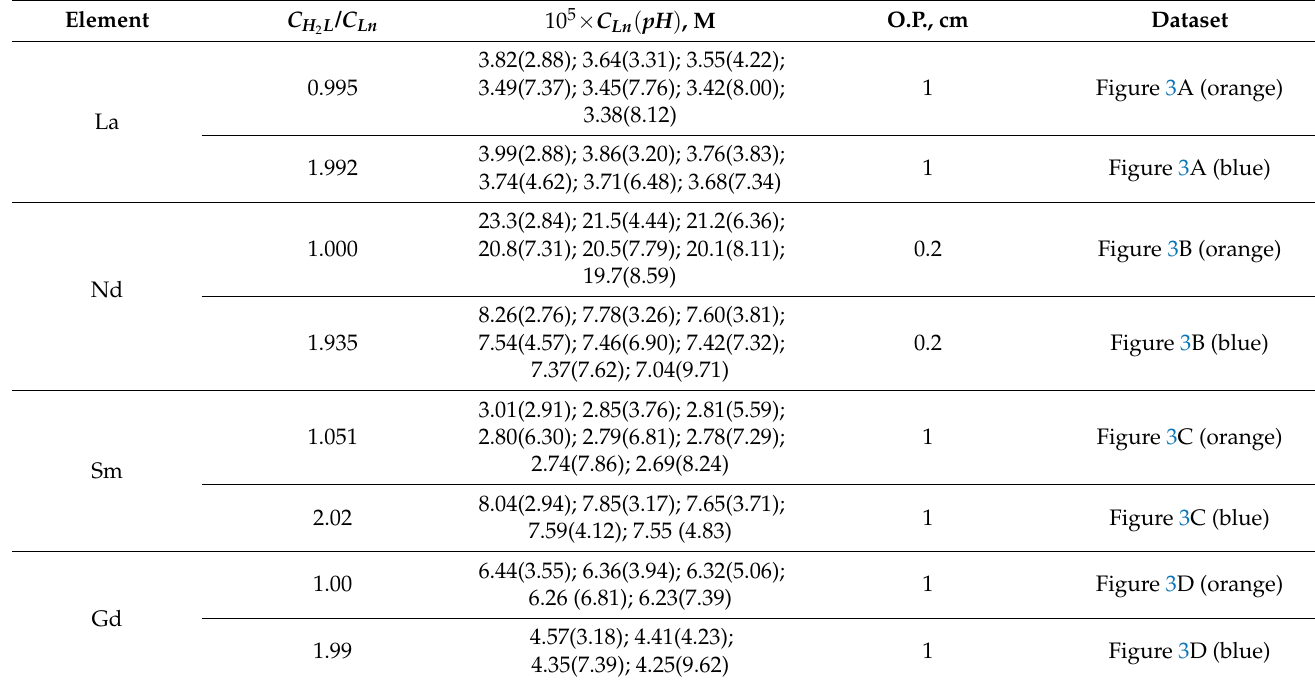
Table 2. Ratios of harzianic acid to Ln 3+ , concentration of Ln 3+ , and pH employed to acquire spec- trophotometric data in Figure 3. The last column relates the reported data to their corresponding curves in Figure 3. O.P. = optical